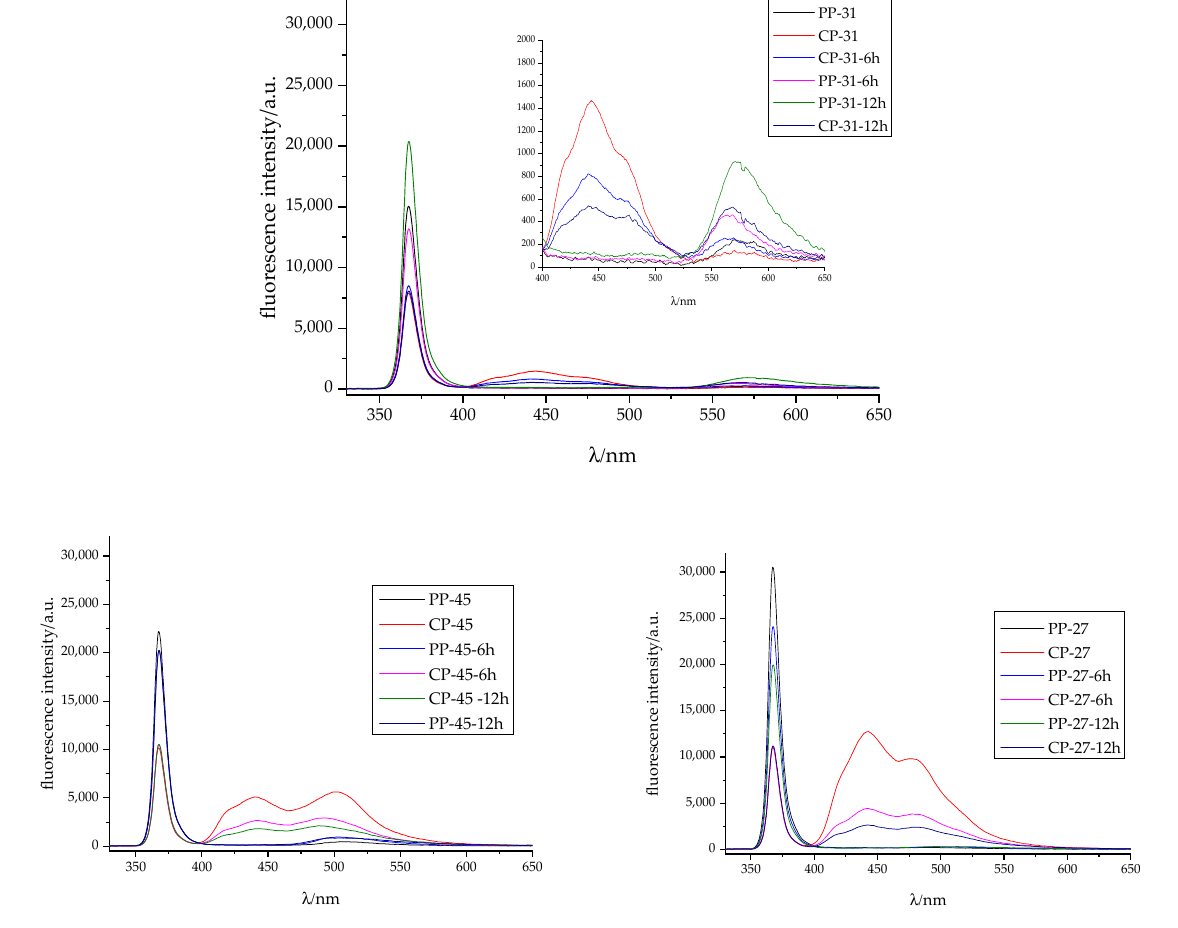
Figure 11. Fluorescence intensity spectra of the TC31, TC45 and TC27 prints on cellulose-based and polypropylene-based paper before and after exposure to UV radiation.